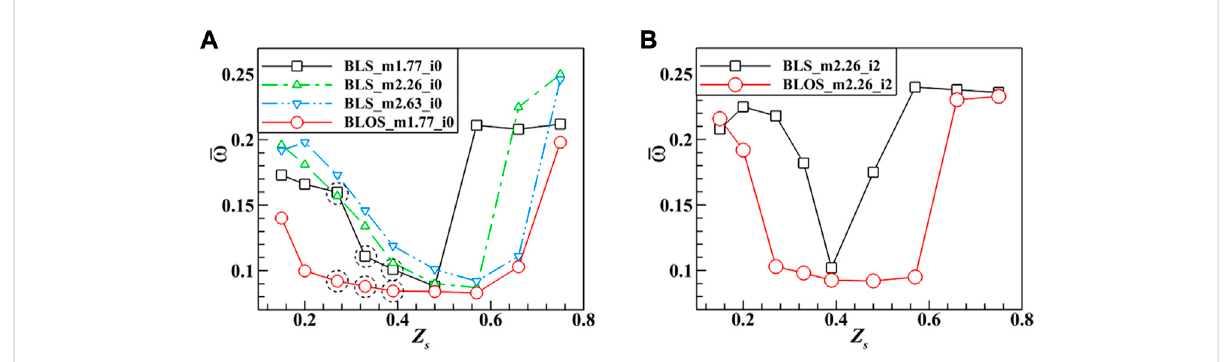
FIGURE 10 Distribution of time averaged total pressure loss according to the suction location in the control of BLOS and BLS. (A) m s = 1.77%, i = 0 o and (B) m s = 2.26%, i = 2 o